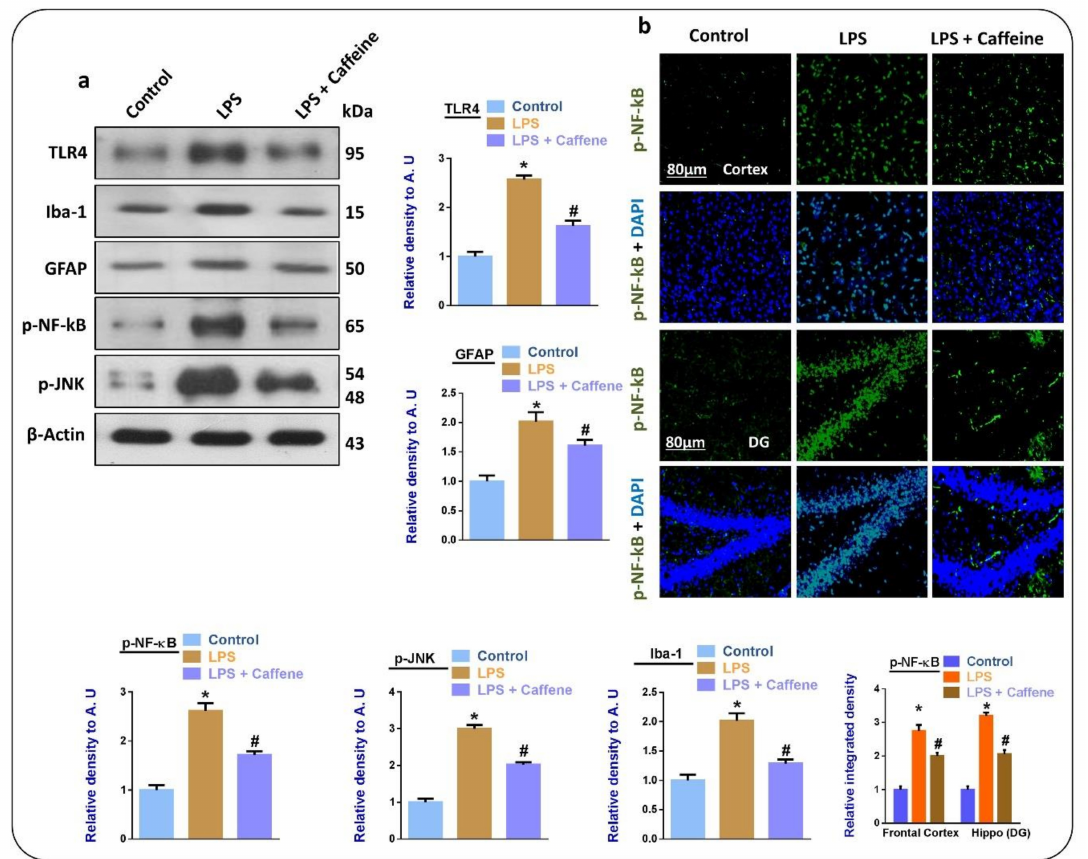
Figure 2. Ca ff eine inhibits LPS-induced glial cell neuroinflammatory mediators in mouse brain: ( a ) Western blot results of TLR4, GFAP, Iba-1, p-NF-kB, and p-JNK in the brains of the